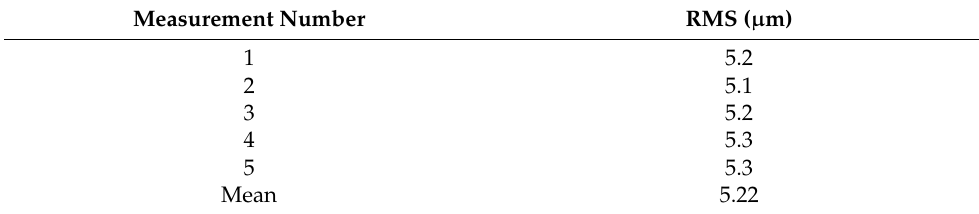
Figure 13. ( a ) The object measured by the system, ( b ) the measurement error of the system, ( c ) the object measured by a profilometer, and ( d ) the measurement error of the profilometer. Table 7. The results of repeated measurement of the F-theta